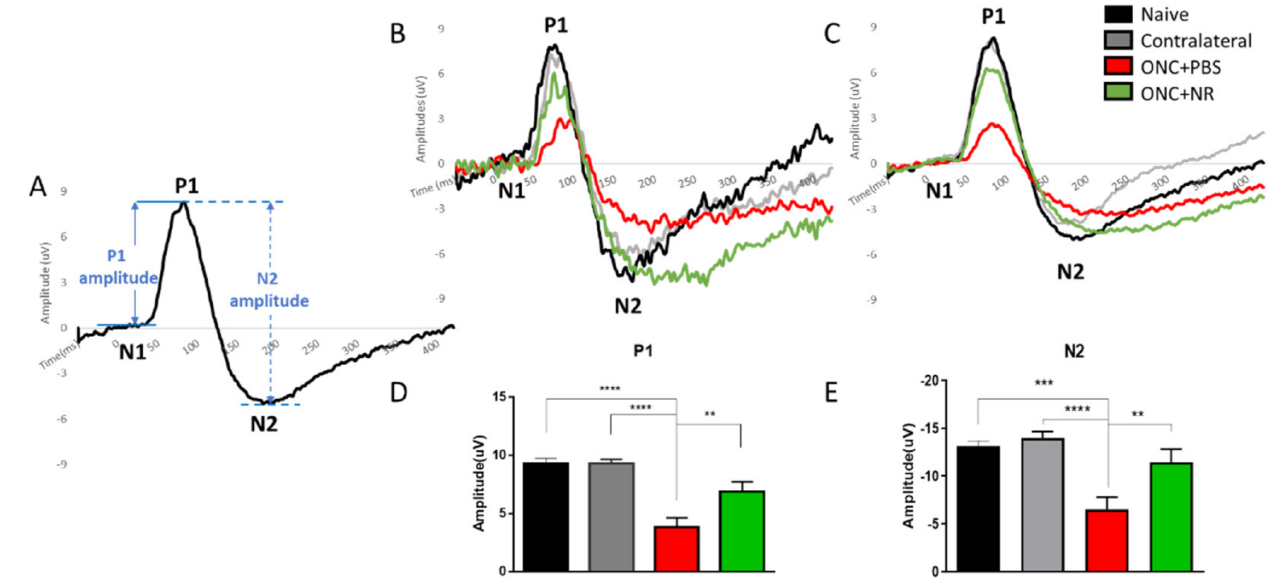
Figure 2. NR treatment preserved RGC function following ONC. ( A ). Representative example of pERG waveform and measurements of P1 and N2 amplitudes. ( B ). Representative pERG waveforms of one eye of a single mouse from each treatment group. ( C ). Composite pERG waveforms of all eyes from each treatment group. ( D ). Quantification of P1 mean amplitudes of the four treatment conditions. P1 mean amplitude of mice that underwent ONC and had been i.p. injected with PBS (red) was significantly diminished compared to the means of contralateral (gray) or naïve (black) cohorts. This diminution was partially but significantly prevented in mice that underwent ONC but had been i.p. injected with NR (green). ( E ). N2 mean amplitude of mice that underwent ONC and had been i.p. injected with PBS (red) was significantly diminished compared to the means of contralateral (gray) or naïve (black) cohorts. This diminution was prevented in mice that underwent ONC that had been i.p. injected with NR (green). ** p < 0.01, *** p < 0.001, **** p < 0.0001, one-way ANOVA with post-hoc Newman-Keuls test. N = 11–18 mice per group. Error bars represent